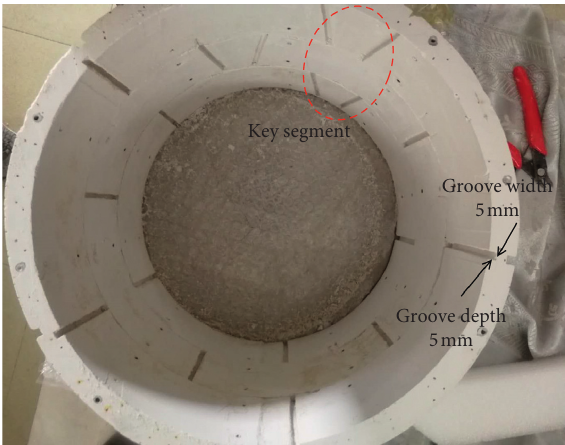
Figure 7: Circumferential joint processing diagram.